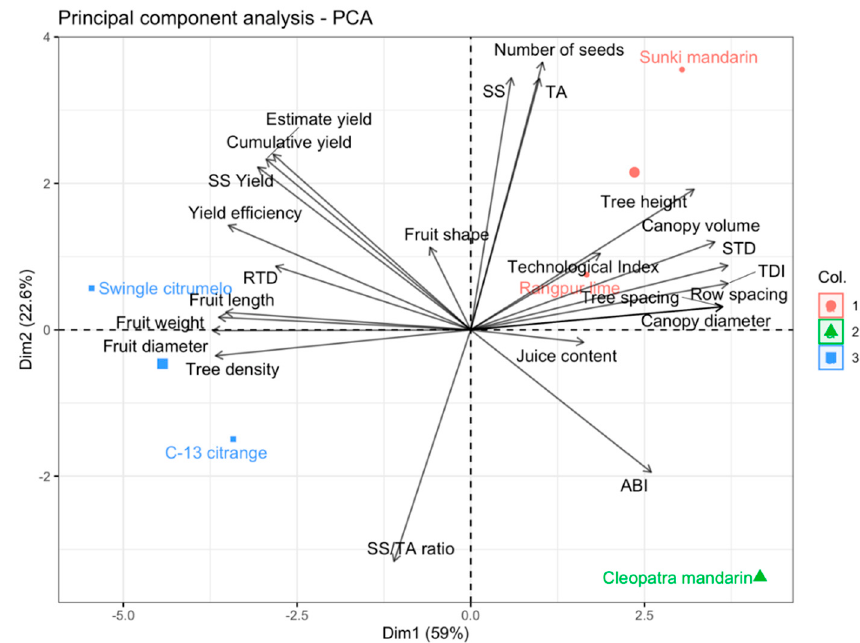
Figure 3. Principal component analysis (PCA) for vegetative growth, yield, and fruit quality variables of ‘Shamouti’ sweet orange trees grafted on different rootstocks. The variables were arranged according to their principal component scores and the individuals (rootstocks) were grouped into three distinct clusters (Col.): 1, 2, and 3. Variables: tree height (m); canopy volume (m); canopy di-